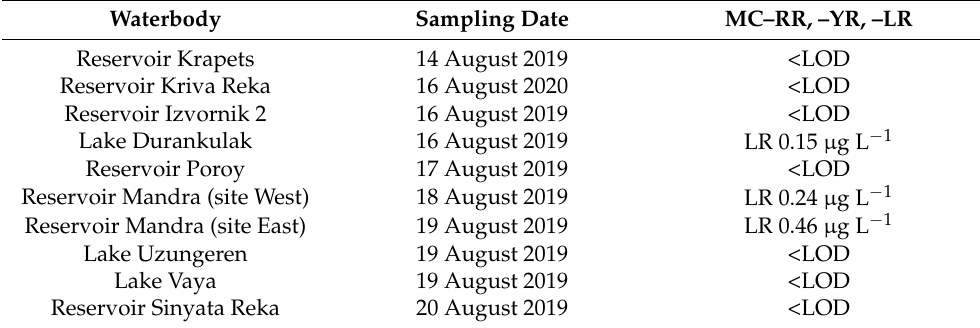
Table 3. Microcystins (MC–RR, -YR and -LR) in water samples from nine shallow Bulgarian water- bodies in August 2019. Limit of detection (LOD) of the applied method is 0.08–0.15 µ g L − 1